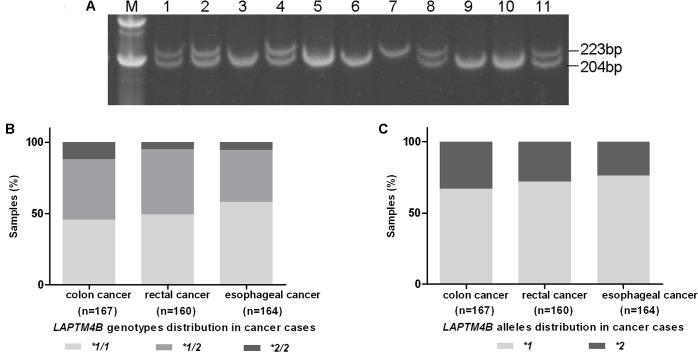
Genotypes of LAPTM4B distribution in colorectal and esophageal cancers.(A) Genotypes of LAPTM4B were separated in 10% polyacrylamide gel electrophoresis. Lanes 1, 2, 4, 8, 11: LAPTM4B *1/2; lanes 3, 5, 6, 9, 10: LAPTM4B *1/1; lanes 7: LAPTM4B *2/2. (B) Distribution of genotypes of LAPTM4B in colorectal and esophageal cancers. LAPTM4B genotypes: *1/1, *1/2 and *2/2 frequencies were 44.6%, 42.3% and 13.1%, respectively, in colon cancer; 49.4%, 45.6% and 5.0%, respectively, in rectal cancer; 57.9%, 36.6% and 5.5%, respectively, in esophageal cancer. (C) Distribution of alleles of LAPTM4B in colorectal and esophageal cancers. LAPTM4B *1 allele frequency was 65.8% in colon cancer; 72.2% in rectal cancer and 76.2% in esophageal cancer. And LAPTM4B *2 allele frequency was 34.2% in colon cancer; 27.8% in rectal cancer and 23.8% in esophageal cancer.